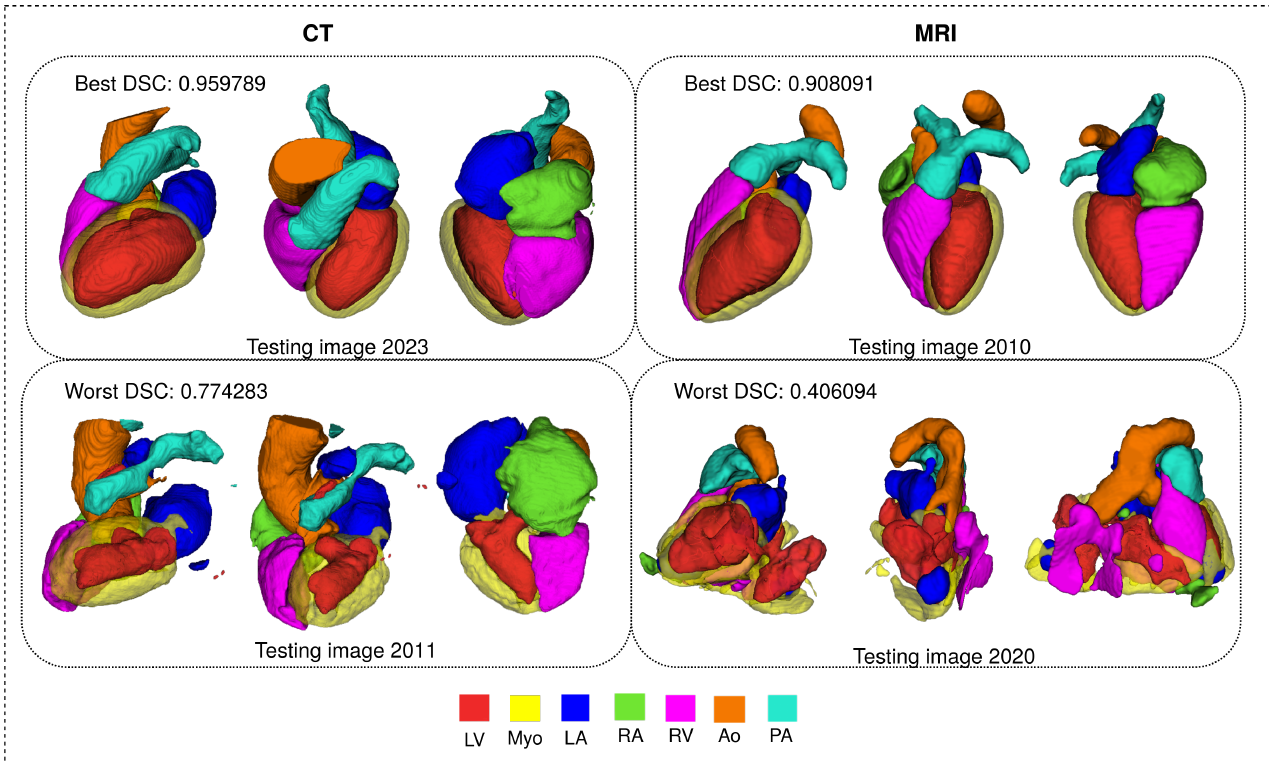
Figure 12. 3D visualization of the best and worse cases of WHS results in the CT and MRI test datasets.